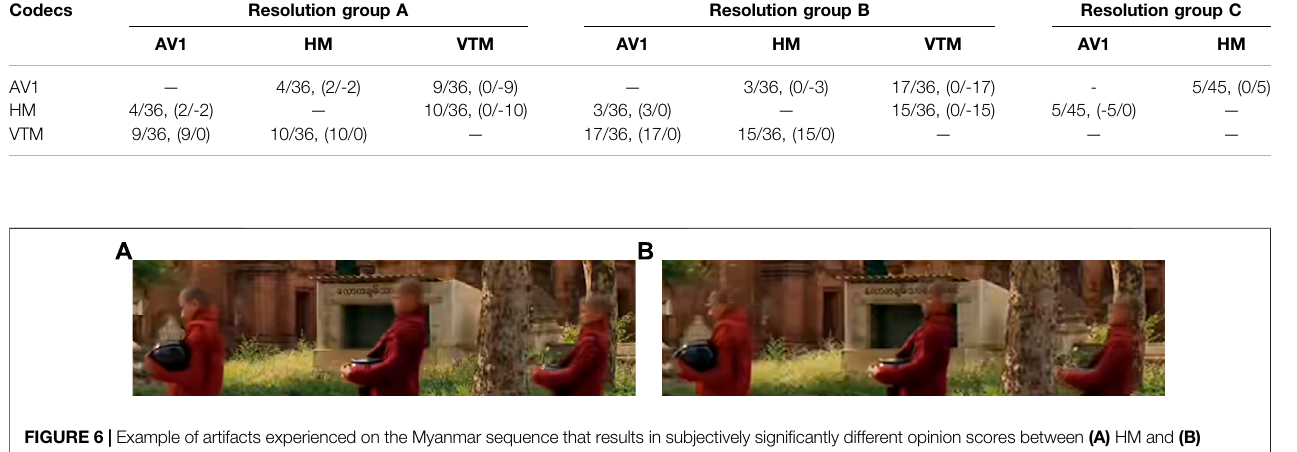
Frontiers in Signal Processing |